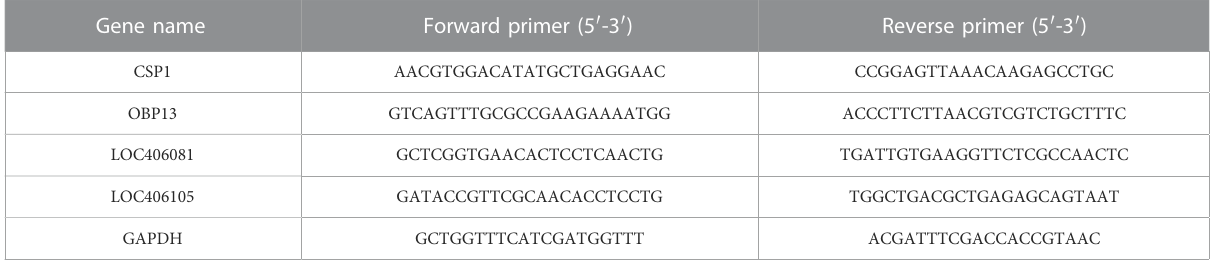
TABLE 1 Gene-speci fi c primers used in quantitative real-time PCR.